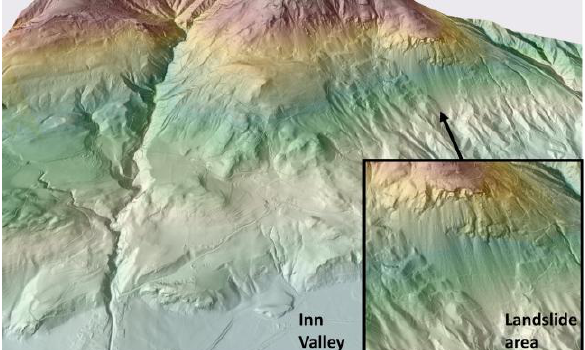
Figure 3. Landslide of the Eiblschrofen in the high resolution terrain model of the province of Tyrol (source: Land Tirol 2009) This model is used in addition for a better location of mining structures. It was manually examined for concave and convex surface structures that are in proximity of the structures identified by Pirkl (Figure 4).